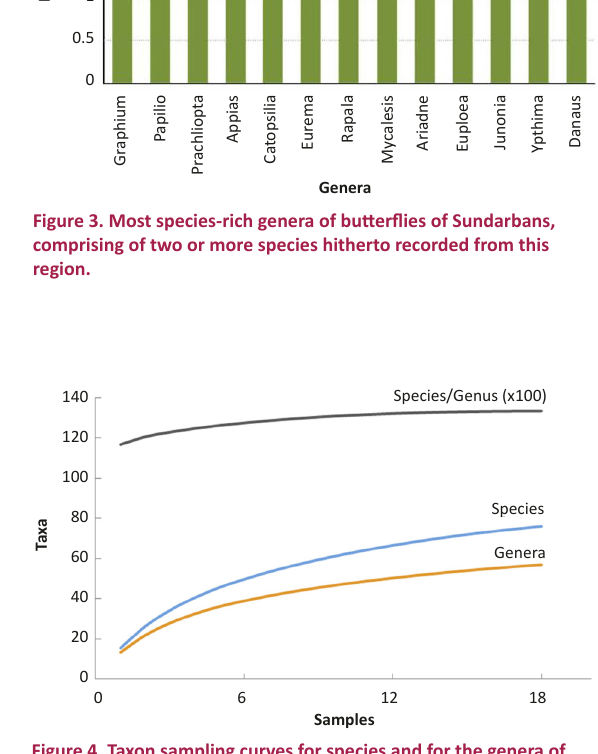
Figure 4. Taxon sampling curves for species and for the genera of butterfly fauna of Indian Sundarbans delta to which they belong, with the species-genus